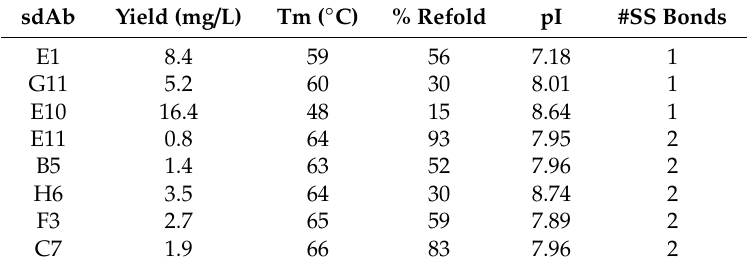
Table 1. Production, CD melting point and refolding, and biophysical properties.